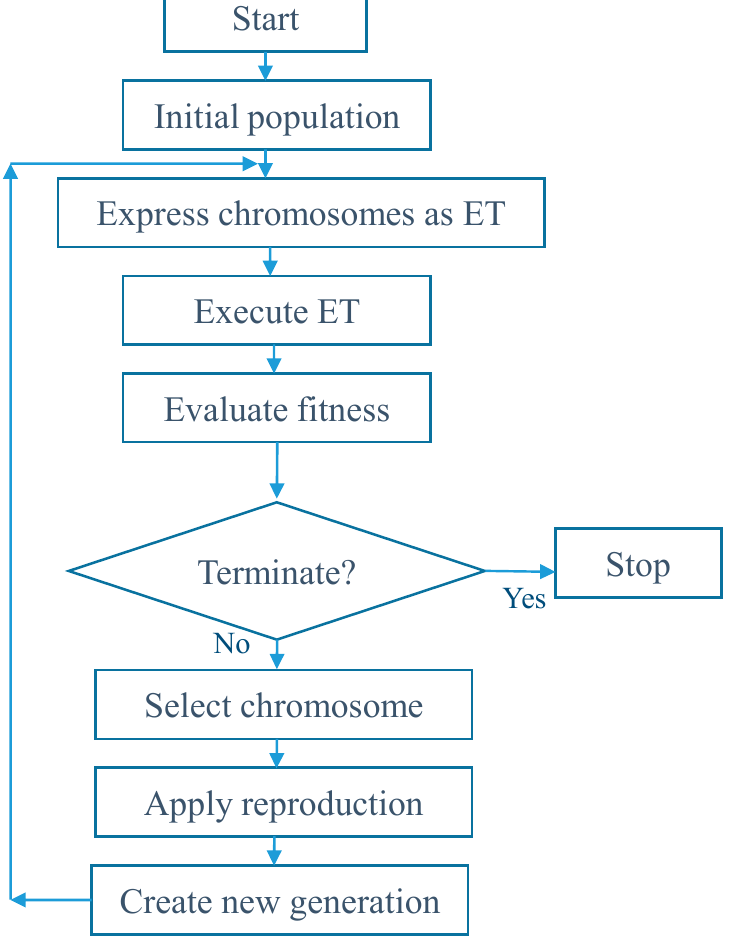
Figure 2. Flowchart of a Ferreira ‐ based adjusted gene expression programming (GEP) algorithm.